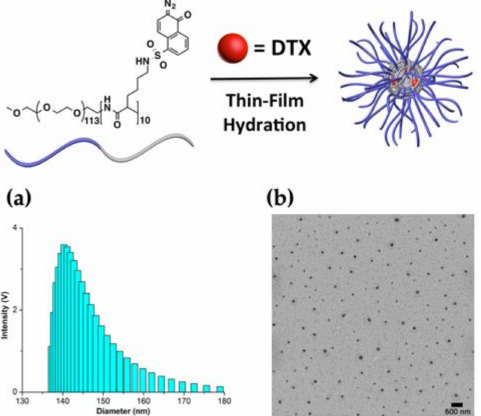
Figure 2. ( a ) DLS size distribution of DTX-NP DNQ ; ( b ) TEM image of DTX-NP DNQ (scale bar = 500